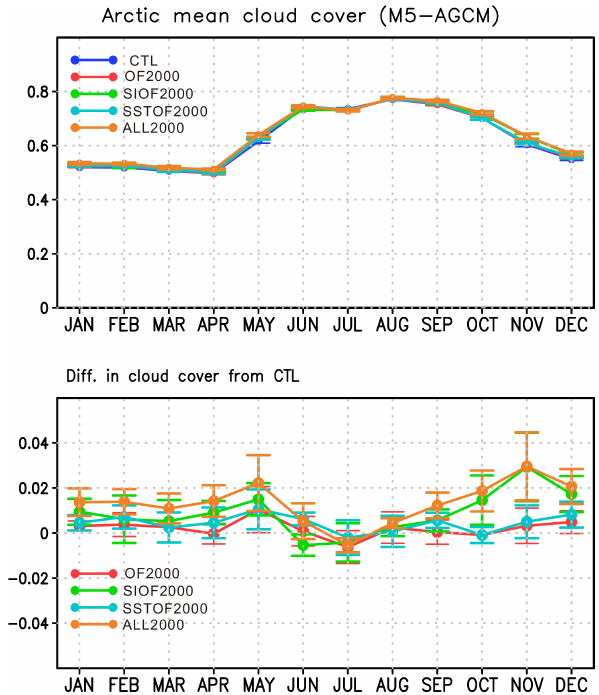
Figure 5. Seasonal cycle of (a) Arctic total cloud cover in each sensitivity simulation using MIROC5-AGCM and (b) the difference from the control experiment.